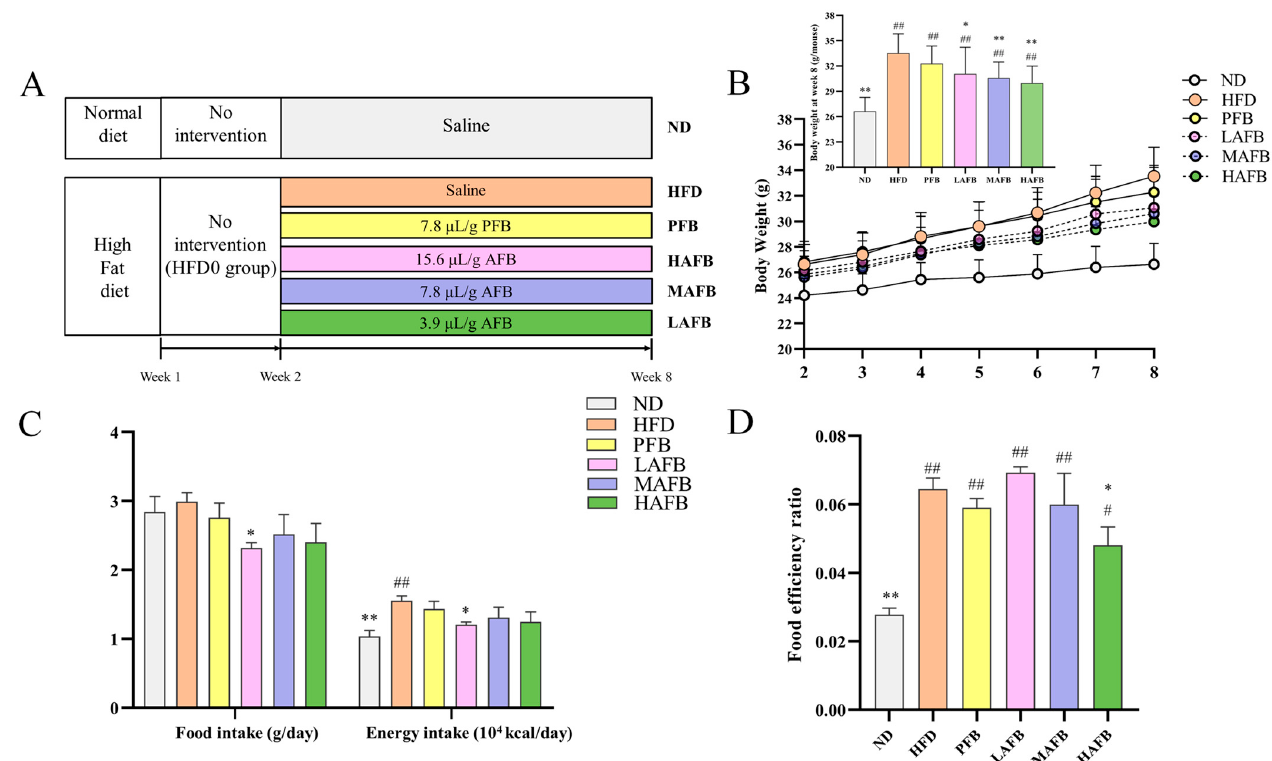
Figure 2. Effect of AFB on body weight, food intake, and food efficiency. ( A ) Schematic diagram of the experiment. ( B ) Growth curve of body weight from week 2 to week 8. ( C ) Average food and energy intake from week 2 to week 8. ( D ) Food efficiency = body weight gain/food intake. The results are expressed as the mean ± SD. * p < 0.05, ** p < 0.01 versus the HFD group and # p < 0.05, ## p < 0.01 versus the ND group by one-way ANOVA.